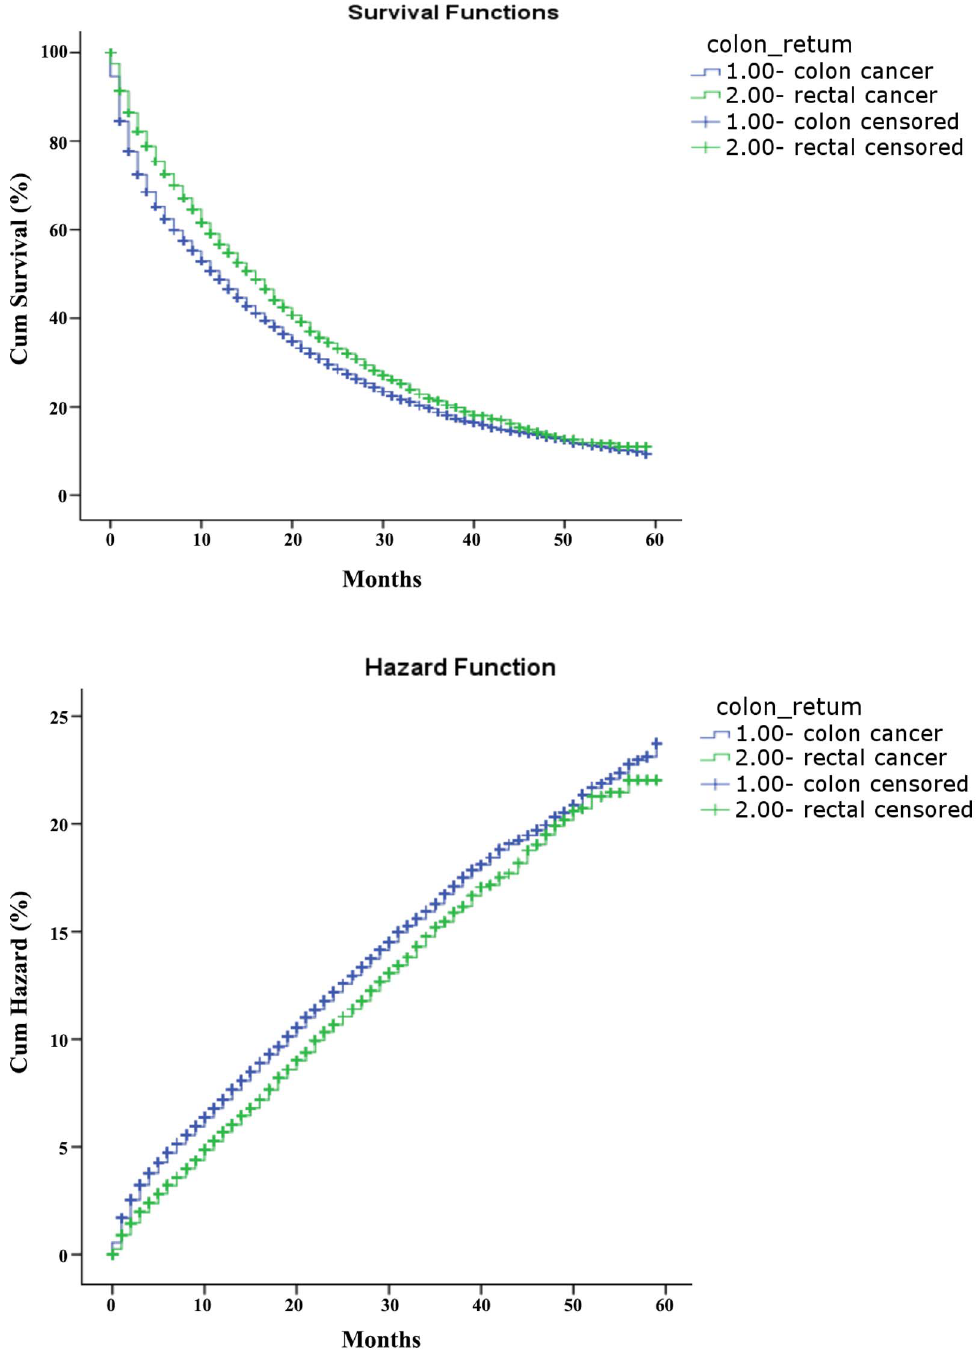
Figure 5. Survival and cumulative hazard of stage IV colon and rectal cancer patients (1, colon cancer; 2, rectal cancer).